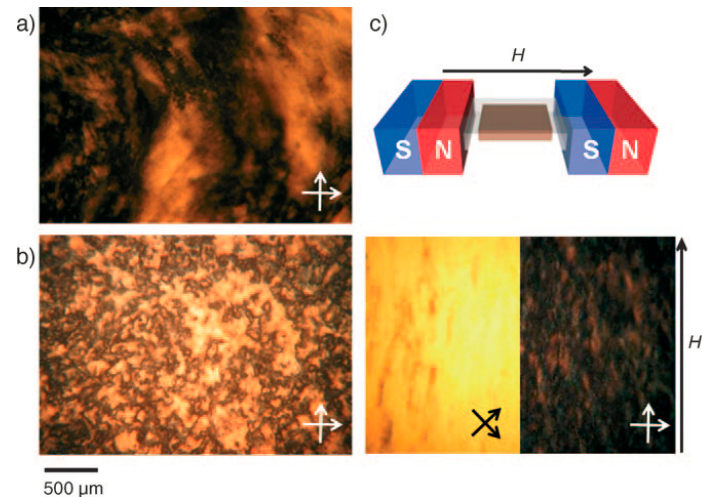
Figure 15. Alignment of aqueous graphene oxide sheets using a magnetic field as reported by Kim et al. [11]. ( a ) POM texture of the nematic GO LC immediately after preparation. ( b ) The texture after 3h with no external field present. ( c ) Schematic diagram showing the magnetic field set-up and POM textures of the aligned GO LC. Reproduced from ref. [11] with permission from John Wiley and Sons.